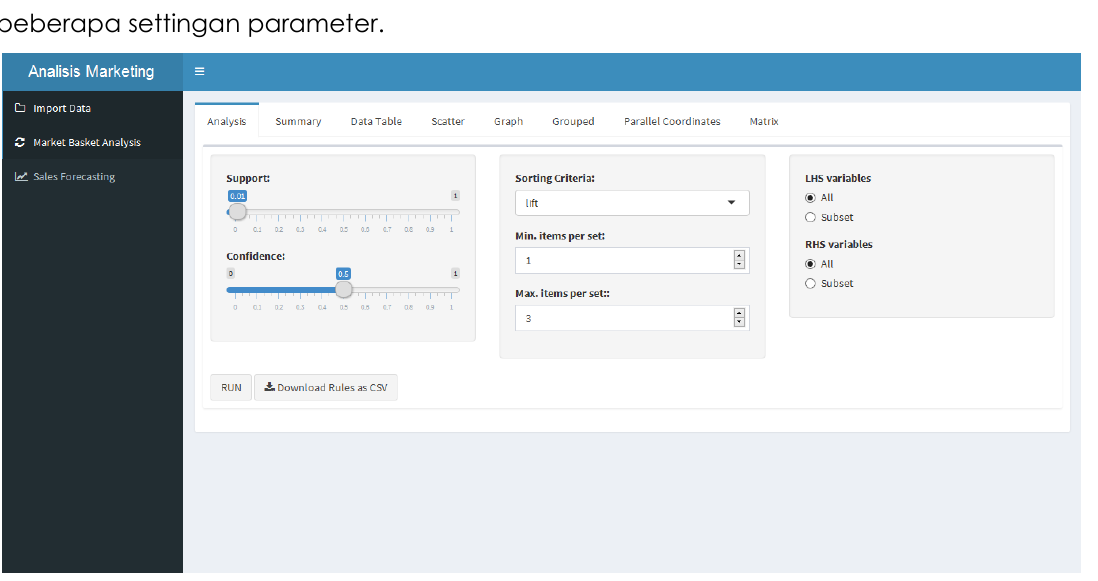
Data table merupakan bagian inti dari Market Basket Analysis . Pada bagian ini menunjukkan hasil olahan data tentang asosiasi kombinasi item produk yang tepat berdasarkan pola belanja